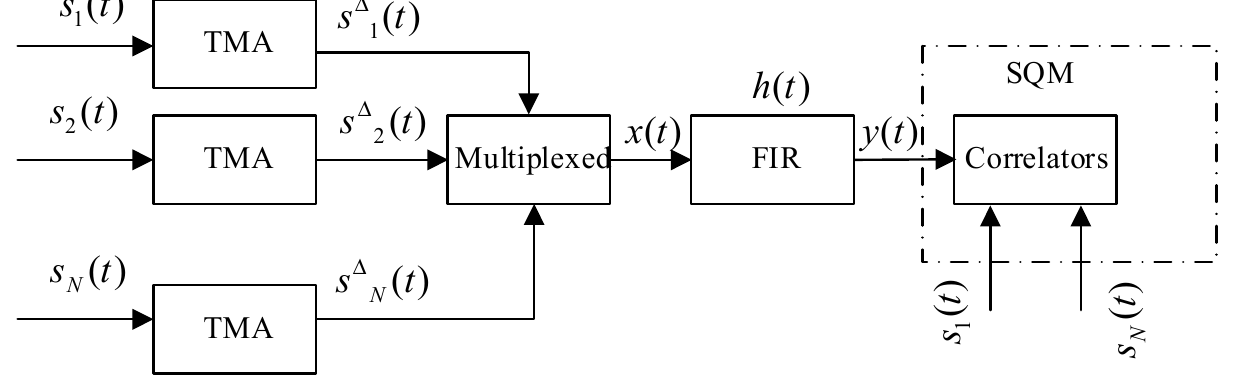
Figure 2. Signal distortion model on navigation payload.